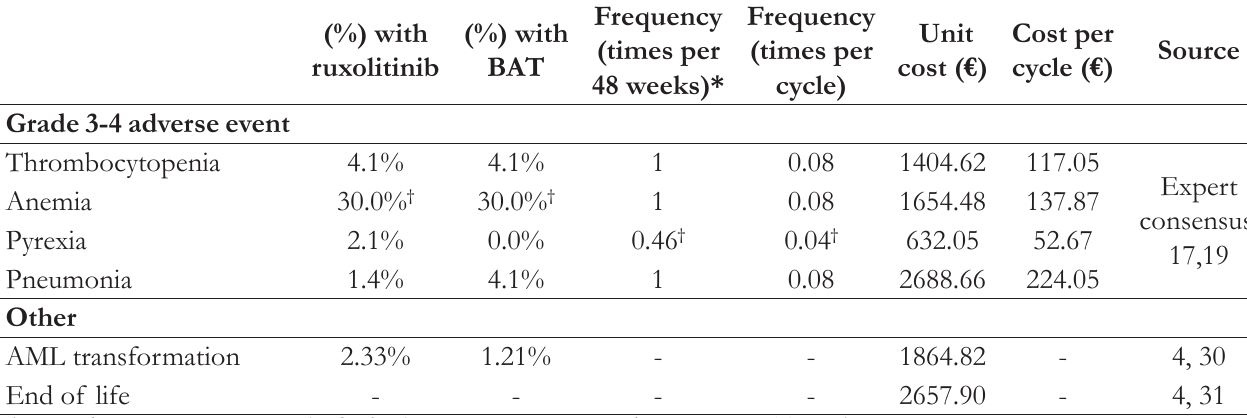
Table 3. Adverse Events, AML Transformation and End-of-life-related Costs (%)